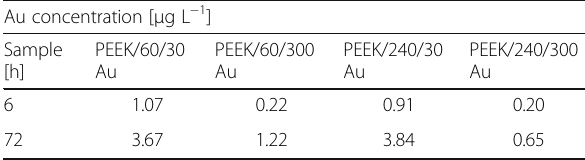
Table 3 Concentration of Au in PBS solution after 6 and 72 h of static incubation with TCPS, pristine PEEK, and PEEK with interfaces of plasma-treated (60 and 240 s) and Au-sputtered (30 and 300 s) parts. The measurement error was